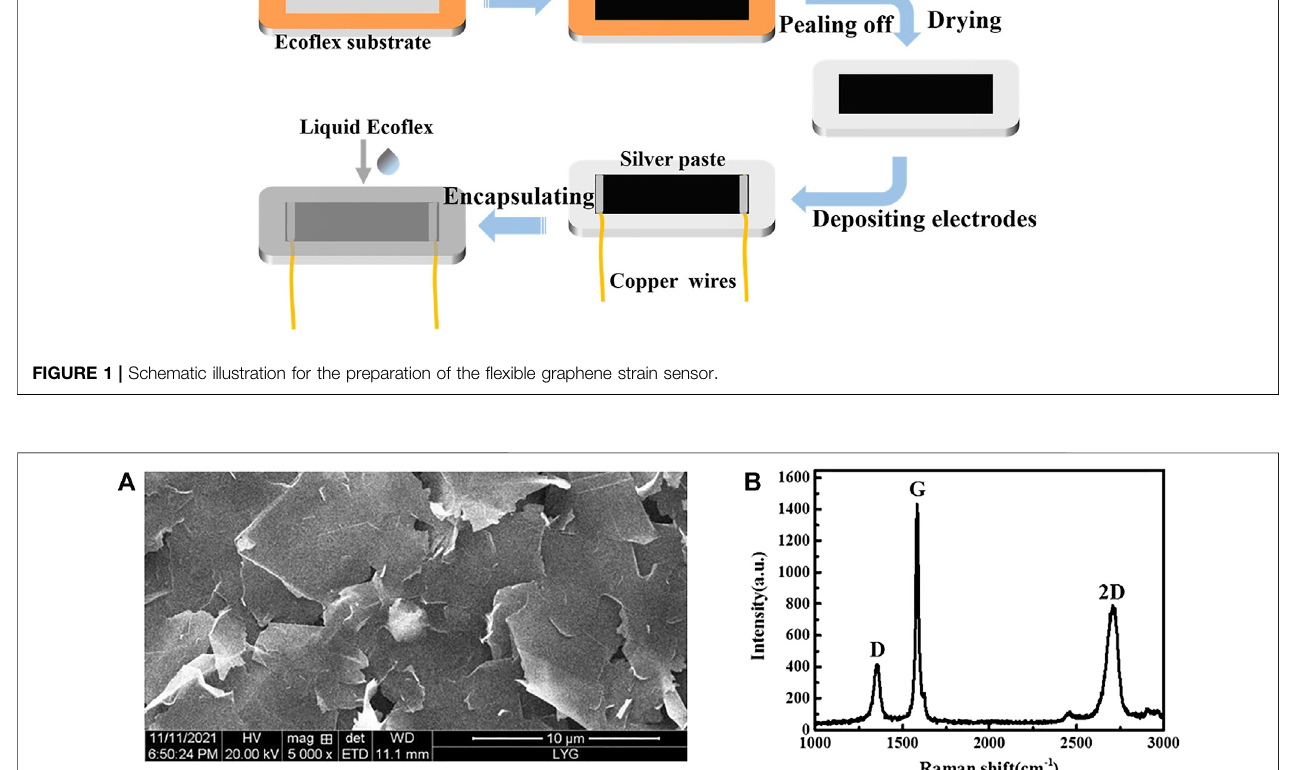
Frontiers in Sensors |